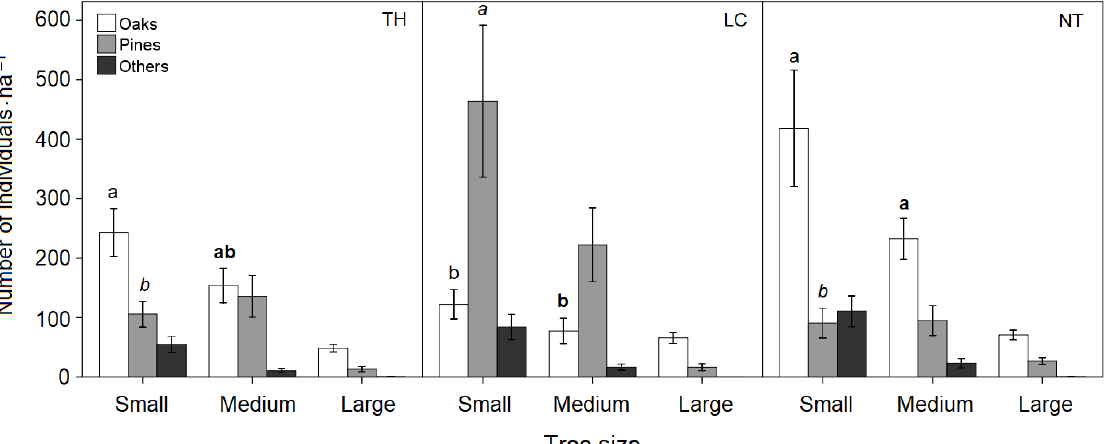
Figure 5. Comparison of density (mean ± standard error) of trees of each species group (Oaks, Pines and Others) for the same size class (small DBH 5–10 cm, medium DBH 11–30 cm and large DBH > 30 cm) in silvicultural treatments in the Ocotones forest, Chiapas. TH = Thinning II, LC = Liberation cut, and NT = No treatment. Densities that differed significantly ( p < 0.05) are shown with different letters above bars. Normal font for Small Oaks comparisons, italics for Small Pines and bold for Medium Oaks.